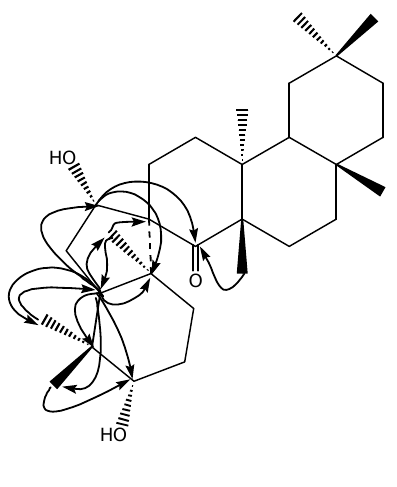
Figure 2. Important HMBC connectivities in 1.